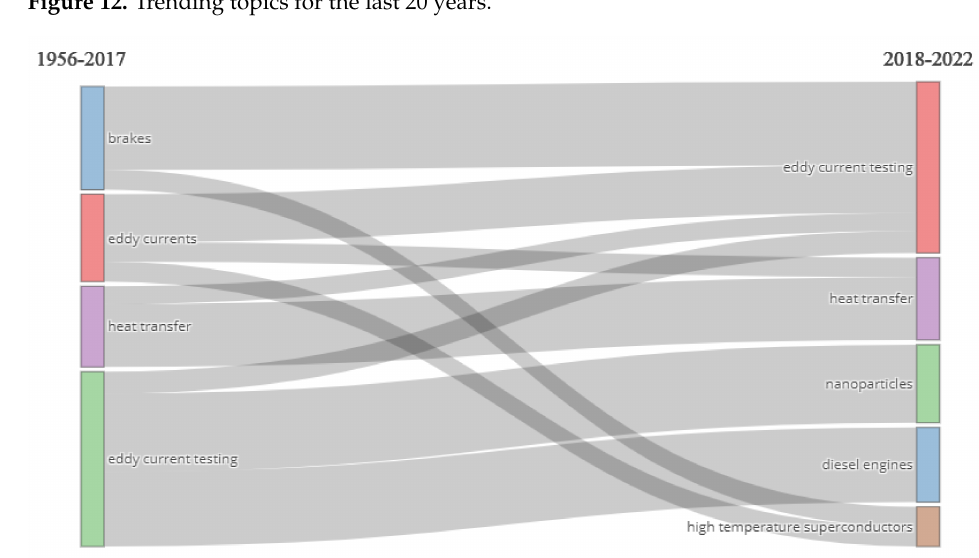
Figure 12. Trending topics for the last 20 years.